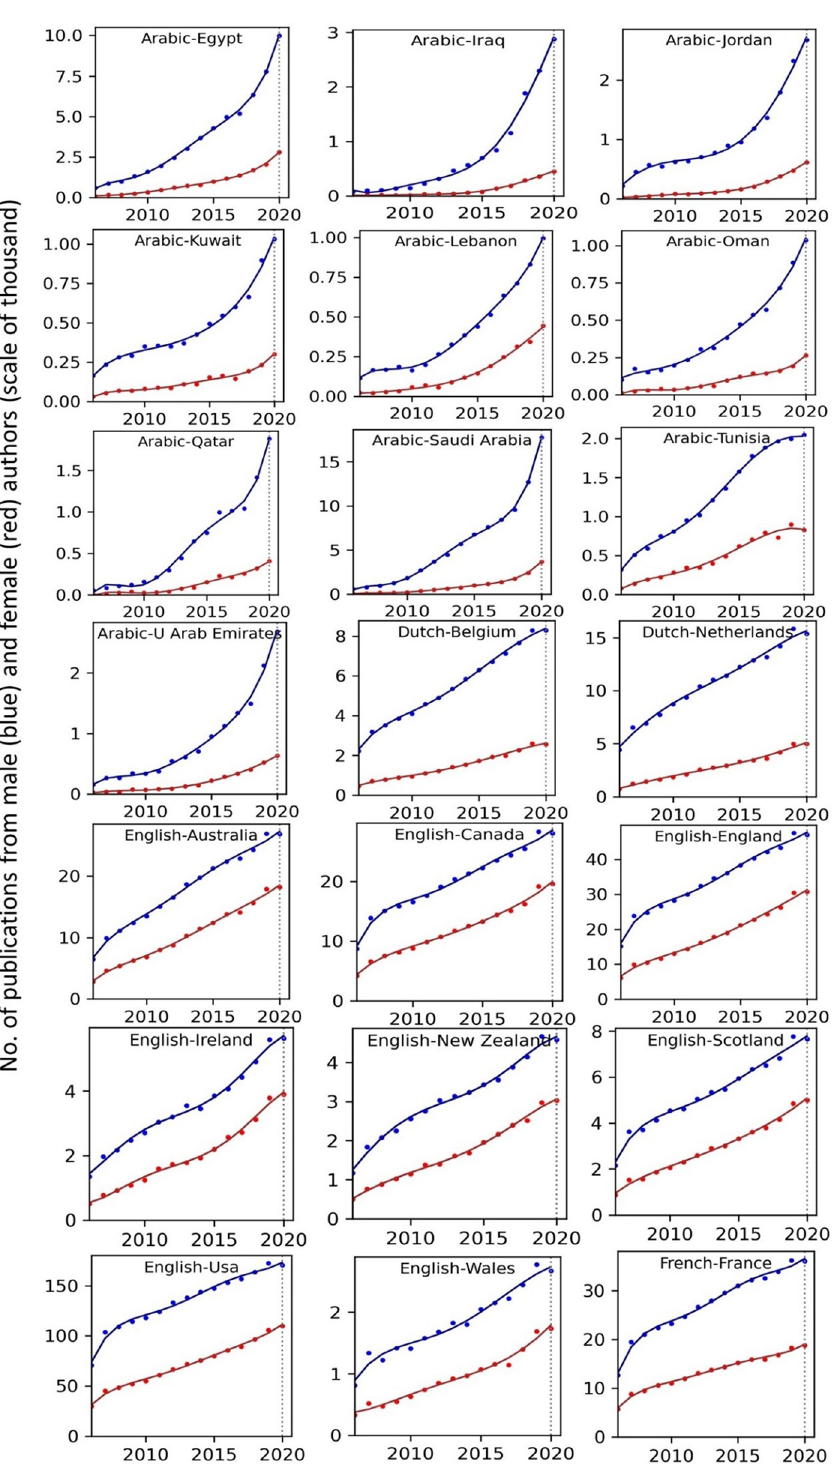
Fig 9. Temporal trends in male (blue lines) and female (red lines) total research productivity based on A-C method (part 1).